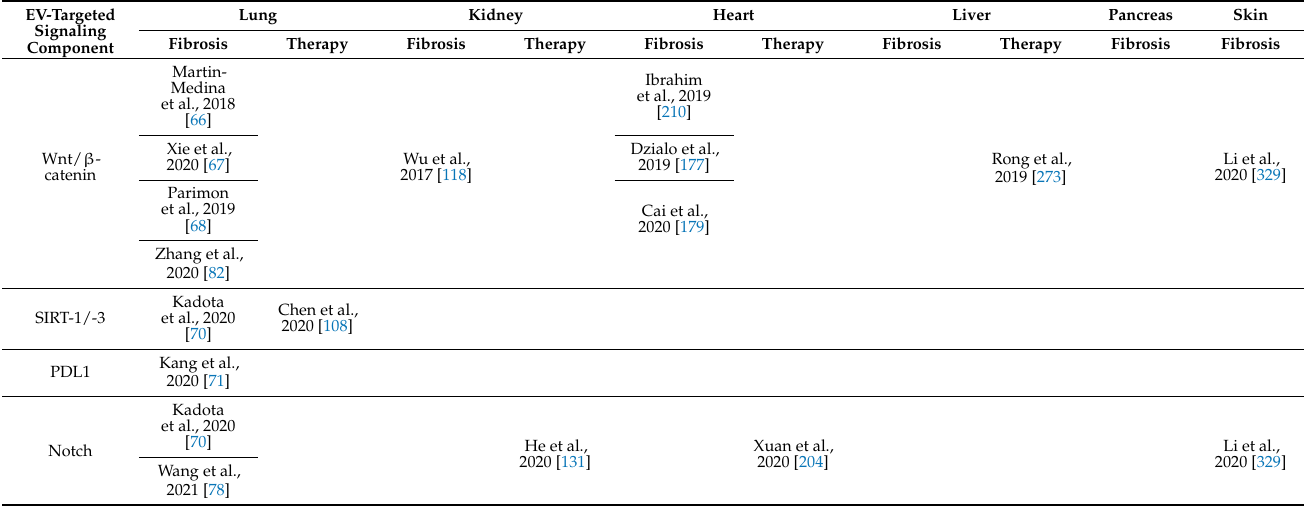
Table 1. Representative examples of fibrosis-related signaling pathways or components that are affected by pathogenic or therapeutic EVs in different organ